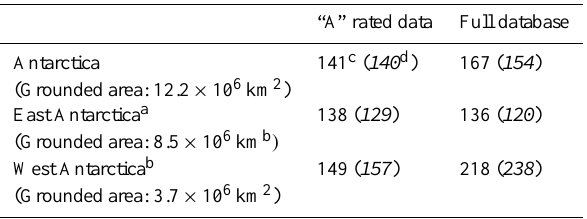
Table 4. Mean SMB computed from field observations for Antarc- tica, and for the eastern and western parts of Antarctica. Note that these SMB averages are only for areas with observation, and do not represent a mean SMB for the whole continent.